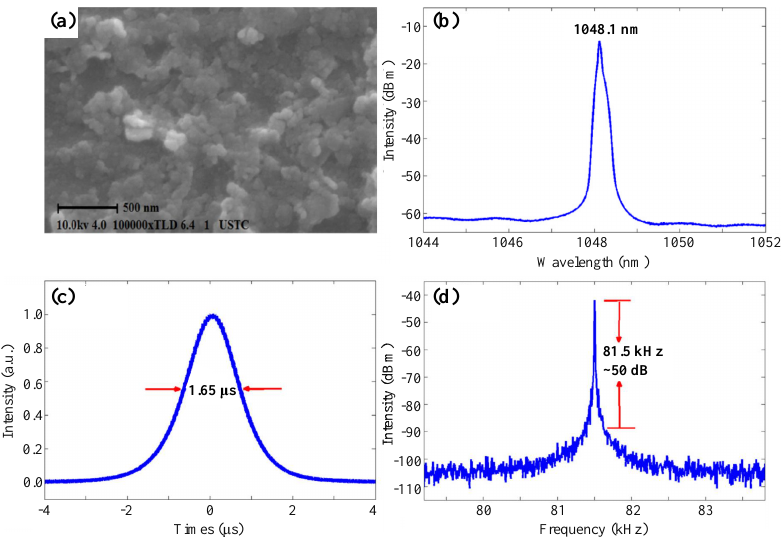
Figure 11. The experimental results of Q-switched THDFL enabled by BP SA. ( a ) SEM image of LPE-grown BP nanoplatelets. ( b ) Single pulse profile, ( c ) output spectrum, and ( d ) RF spectrum at a repetition rate of 113.3 kHz. ( a – d ) adapted from